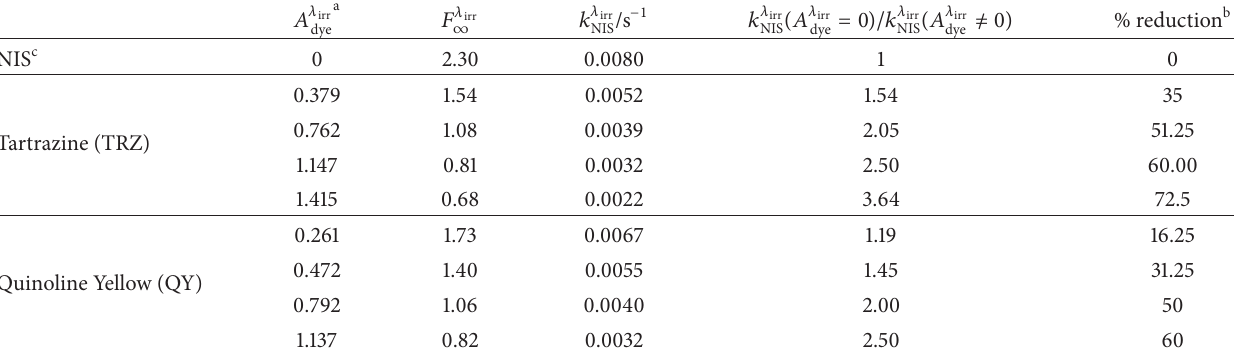
Table 3: Dyes absorbance, overall reaction rate-constants, photokinetic factors, and percentage reduction in reaction rates of NIS photodegradation in the presence of various concentrations of TRZ and QY when irradiated and observed at 390 nm.